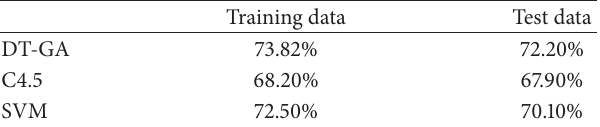
Table 5: Comparison on accuracy.